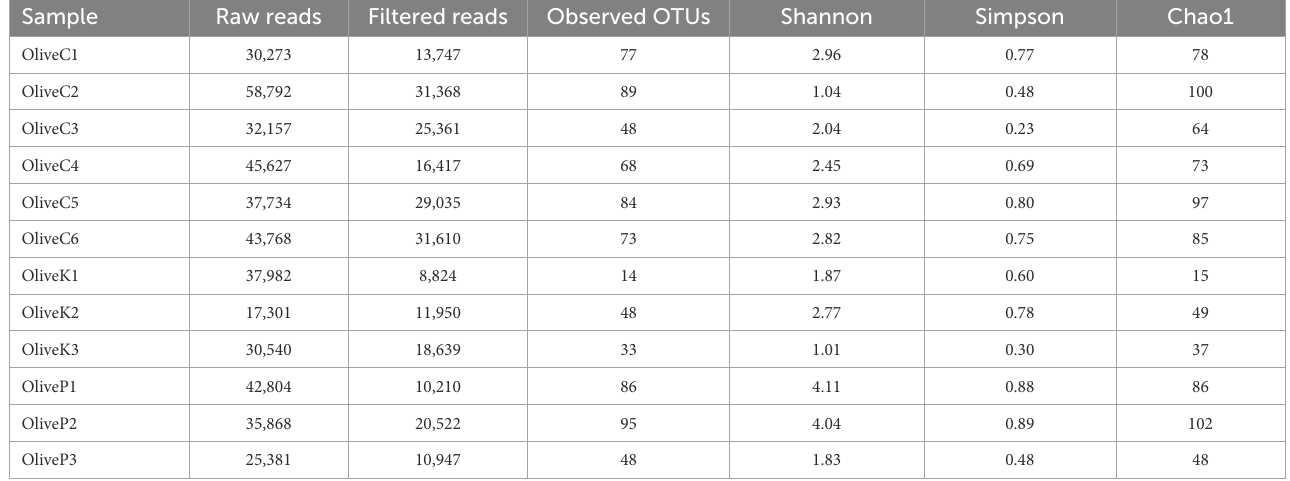
TABLE 3 Number of raw reads, filtered reads, and alpha diversity indices of different olive varieties (Cypriot, Kalamata, Picual) from different regions, as revealed by ITS1 loci high throughput sequencing. Sample Raw reads Filtered